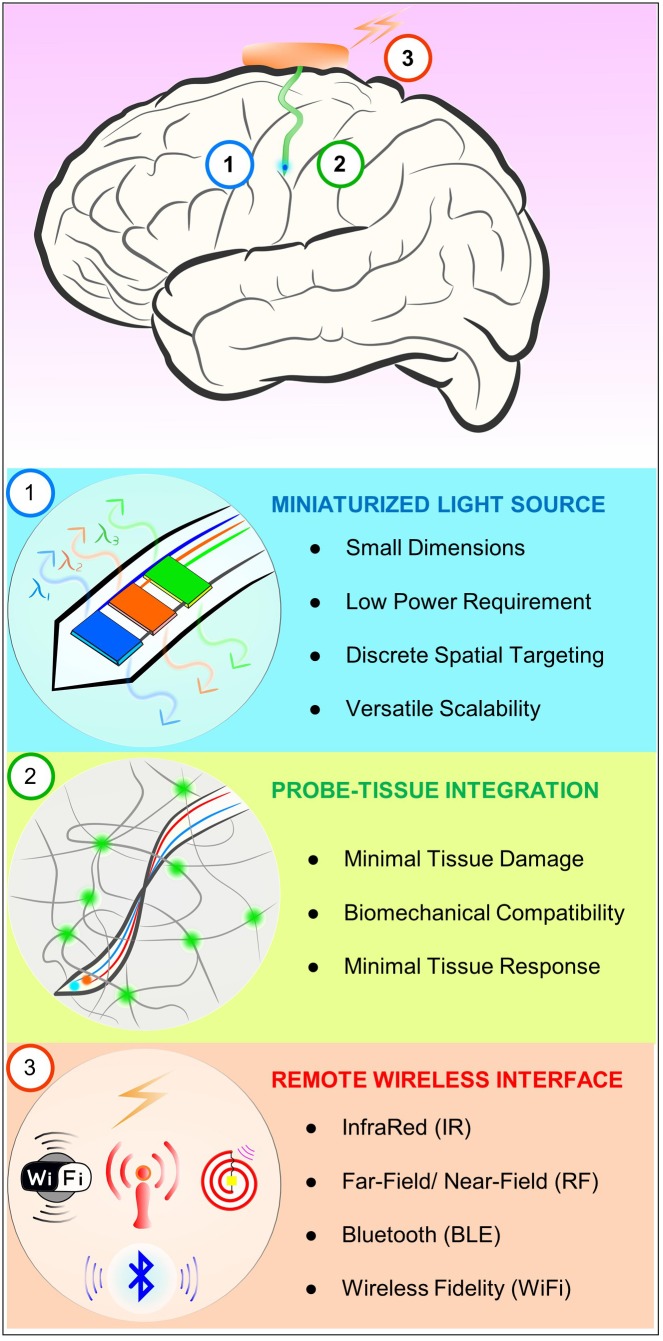
Schematic diagram illustrating desired characteristics of chronic in vivo optogenetic tools for freely behaving animals. Ideally, optogenetic probe systems should have miniaturized light source, biocompatible probe-tissue integration, as well as wireless control capability.